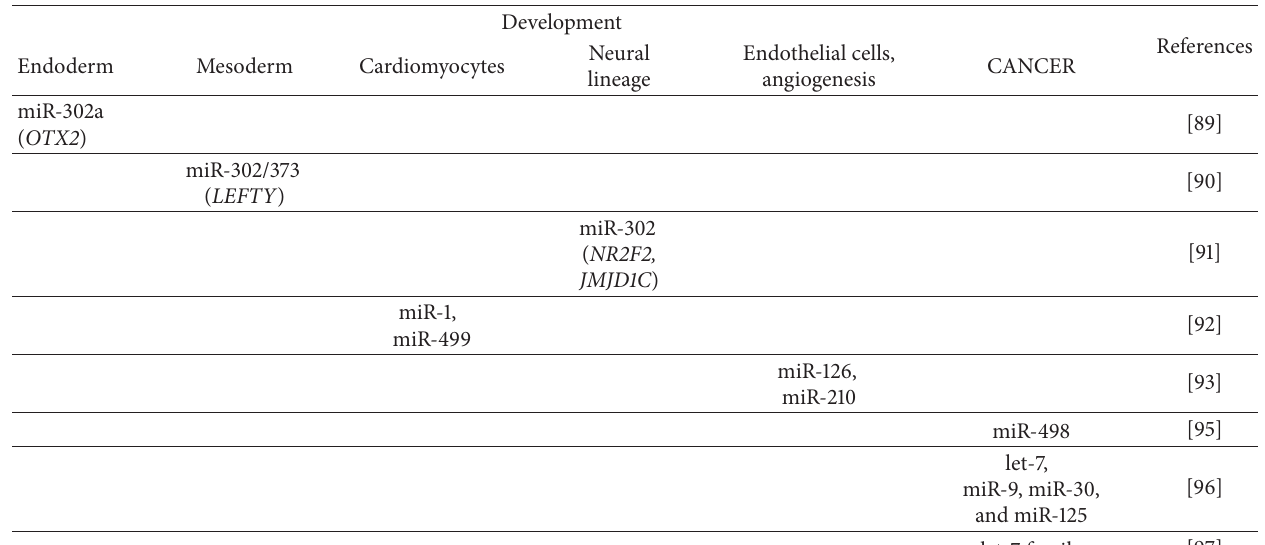
Table 2: MiRNAs and their target genes related to differentiation of hESCs, development of all three germ layers (endoderm, mesoderm, and ectoderm ) , and cancer